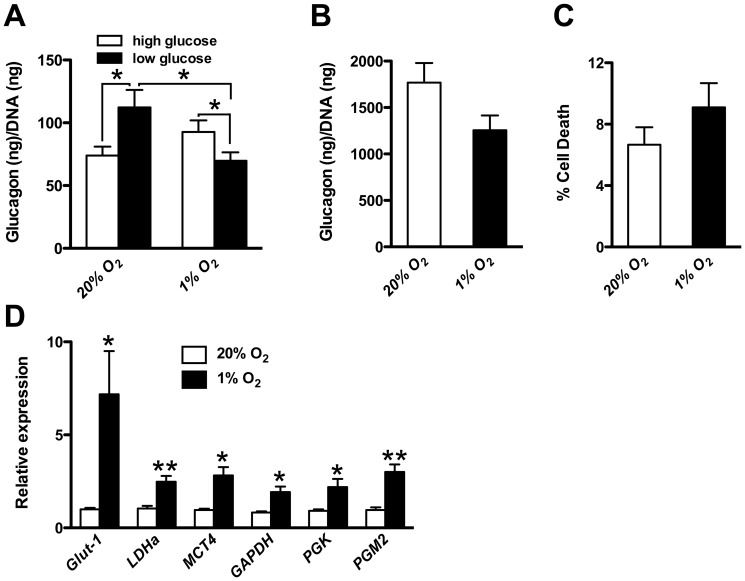
Hypoxia impairs glucagon secretion from α-TC6.1 cells.
A. Glucagon secretion from α-TC6.1 cells cultured under hypoxic conditions (n = 22) is reduced upon incubation in low glucose as compared to cells cultured under normoxic conditions (n = 21 technical replicates of 3 independent experiments). *p<0.05. B. Total glucagon content is not reduced in the cells under hypoxia (n = 6 per condition). C. There is no significant change in cell viability, as assessed by propidium iodine uptake, between normoxic and hypoxic conditions (n = 9 per condition). D. Gene expression analysis of hypoxia targets revealed an upregulation under hypoxic conditions (n = 6 per condition). Error bars represent standard error of the mean in all cases. *p<0.05, **p<0.005.